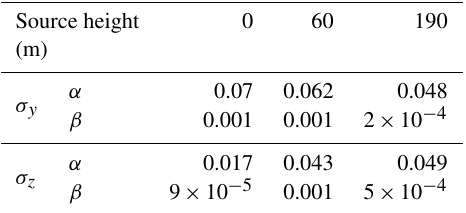
Table 1. Coefficients of horizontal and vertical plume dispersion (Eq. 2) fitted for LES plumes with different source heights. γ = − 0 . 5 remains unchanged from Eq.